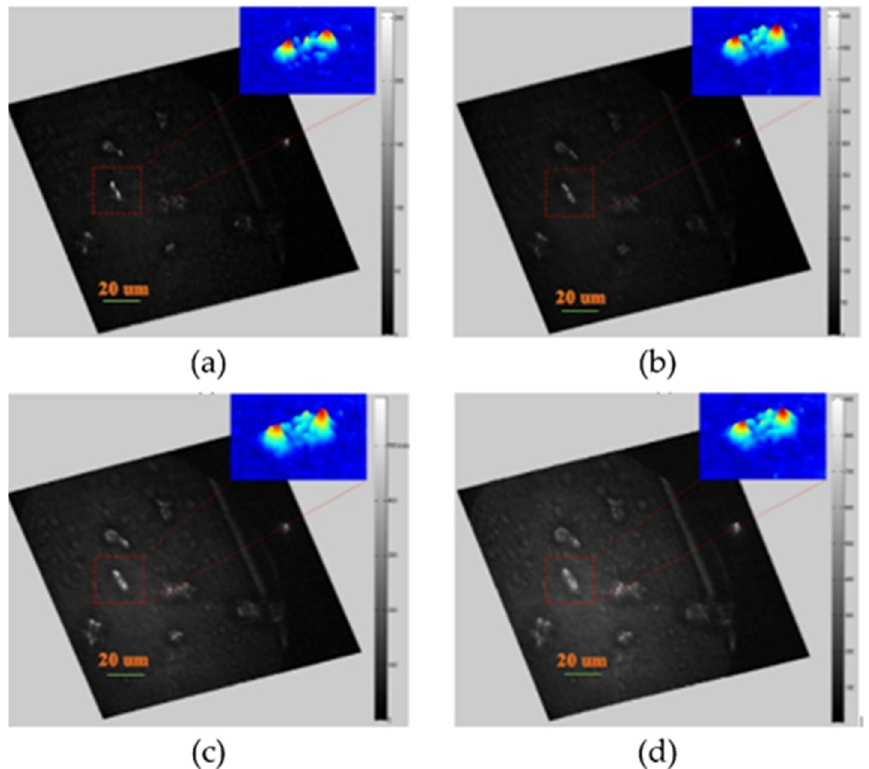
Figure 21. Reconstructed images for cell with ( a ) 2 layer, ( b ) 4 layer, ( c ) 6 layer, and ( d ) 8 layer holograms (adapted from [39]).